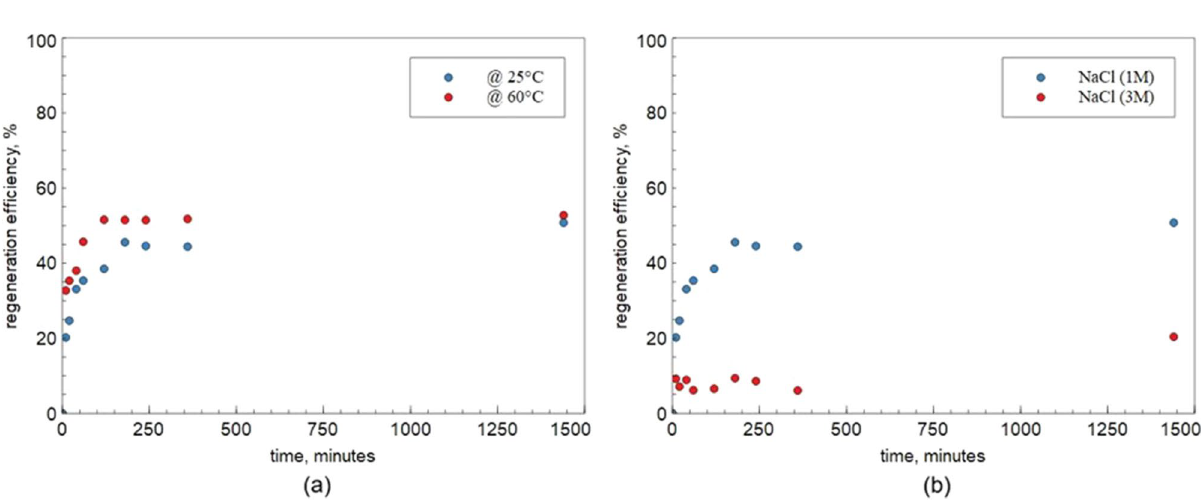
Figure 8. Regeneration efficiency of ZEOP (uncontrolled pH): ( a ) at different temperature and ( b ) at different NaCl concentration.